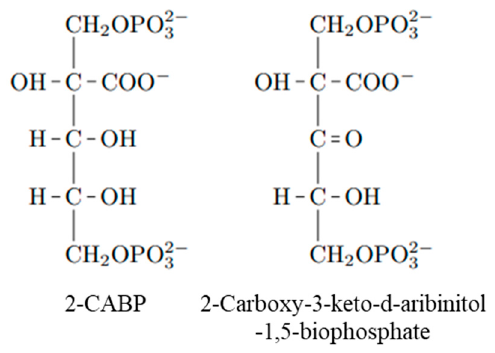
Figure 14. Reaction intermediate analog 2CABP and reaction intermediate 2-carboxy-3-keto-aribinitol-1,5-biophosphate.